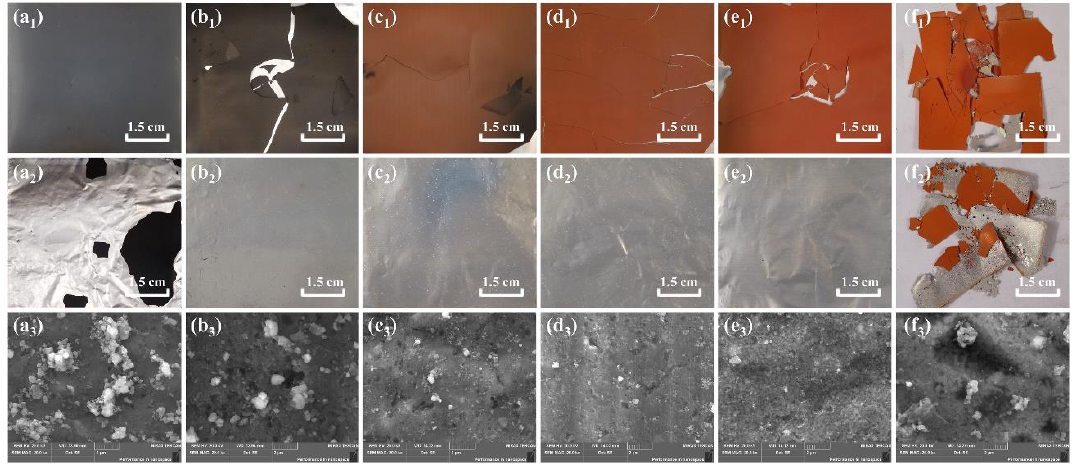
Figure 3. E ff ect of roasting temperature on spent LiFePO 4 cathode plates. ( a 1 – f 1 ) images of cathode Figure 3. Effect of roasting temperature on spent LiFePO 4 cathode plates. ( a 1 –f 1 ) images of cathode plates at 450–700 ◦ C; ( a 2 – f 2 ) images of Al foils at 450–700 ◦ C; ( a 3 – f 3 ) SEM images of Al foils at 450–700 ◦ plates at 450–700 °C; ( a 2 –f 2 ) images of Al foils at 450–700 °C; ( a 3 –f 3 ) SEM images of Al foils at 450–700 °C.